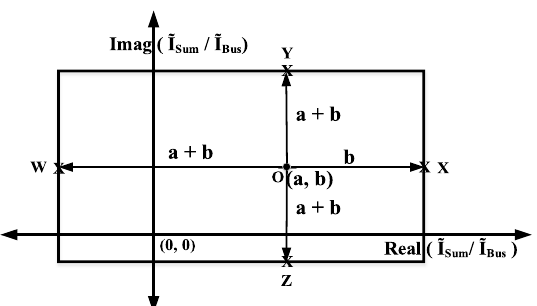
Fig. 3 RR of the proposed scheme